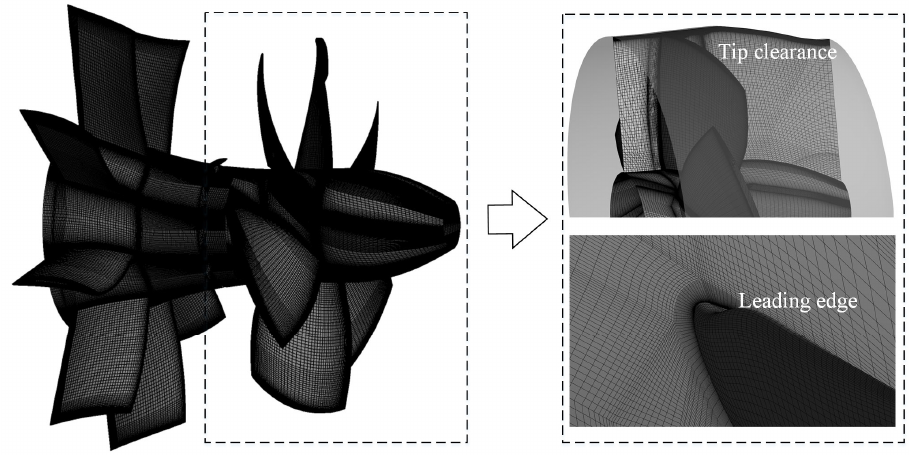
Figure 2. Structured meshes in the pump for Mesh 3.